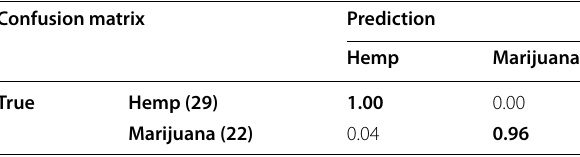
Table 1 Confusion matrix associated with the prediction of “out- of-bag” samples in the random forest model